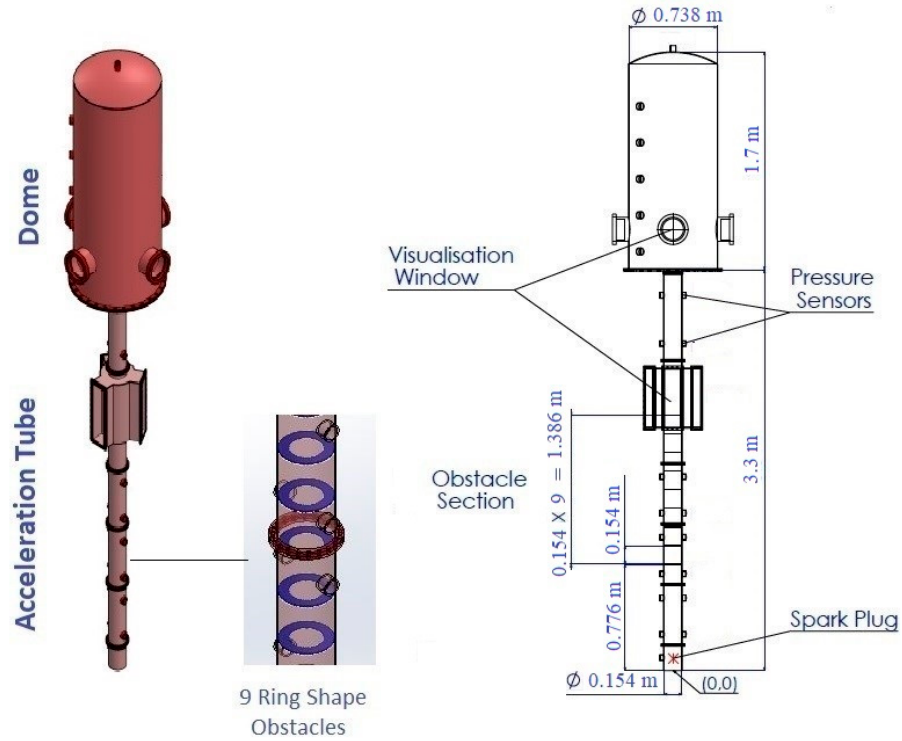
Figure 1. The schematic of the combustion chamber [17].